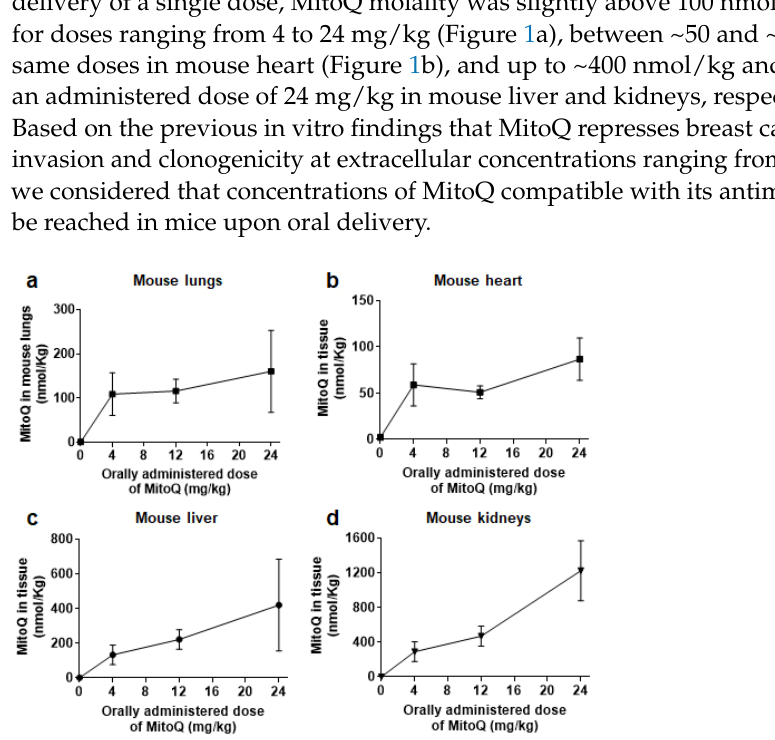
Figure 1. MitoQ biodistribution in mouse tissues. Female BALB/c mice received increasing doses of MitoQ per os, and tissues were collected 4 h later for analysis using LC/MS/MS. ( a ) MitoQ molality in function of the administered dose of MitoQ in mouse lungs ( n = 3–4), ( b ) as in a, but in mouse heart ( n = 5). ( c ) As in a, but in mouse liver ( n = 3–6). ( d ) As in a, but in mouse kidneys ( n = 3–5). All data are shown as means ±